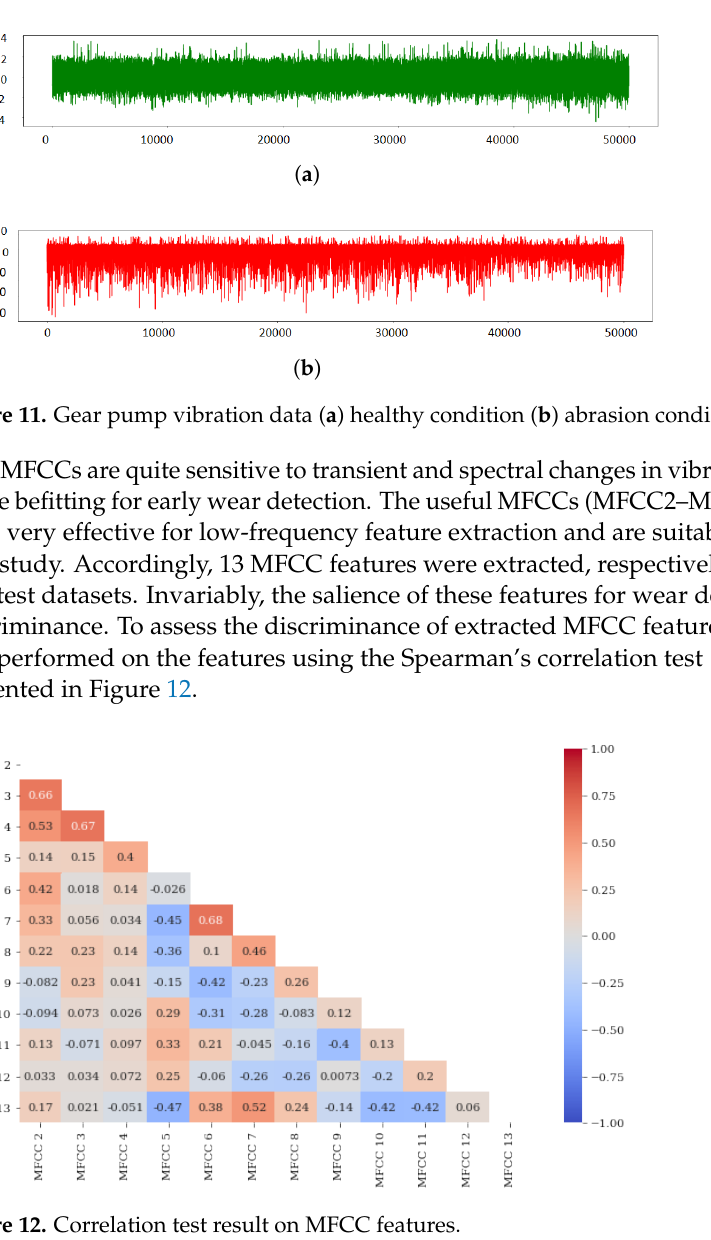
Figure 12. Correlation test result on MFCC